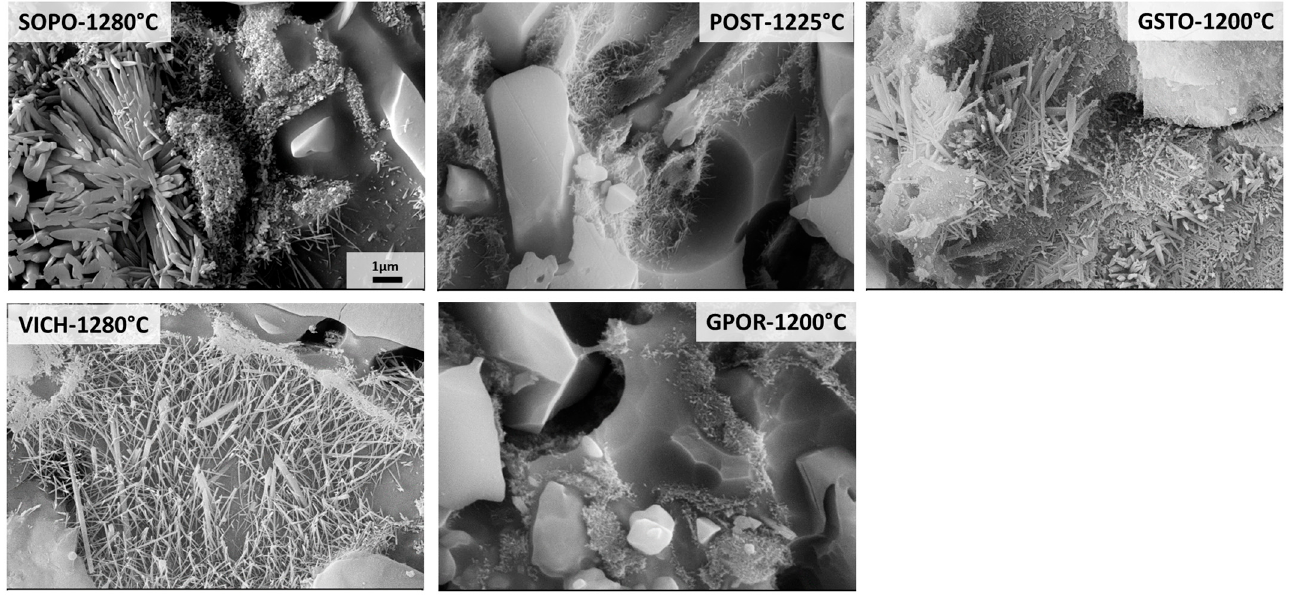
Figure 8. SEM micrographs after HF etching for mullite observations (scale bar = 1 µm).